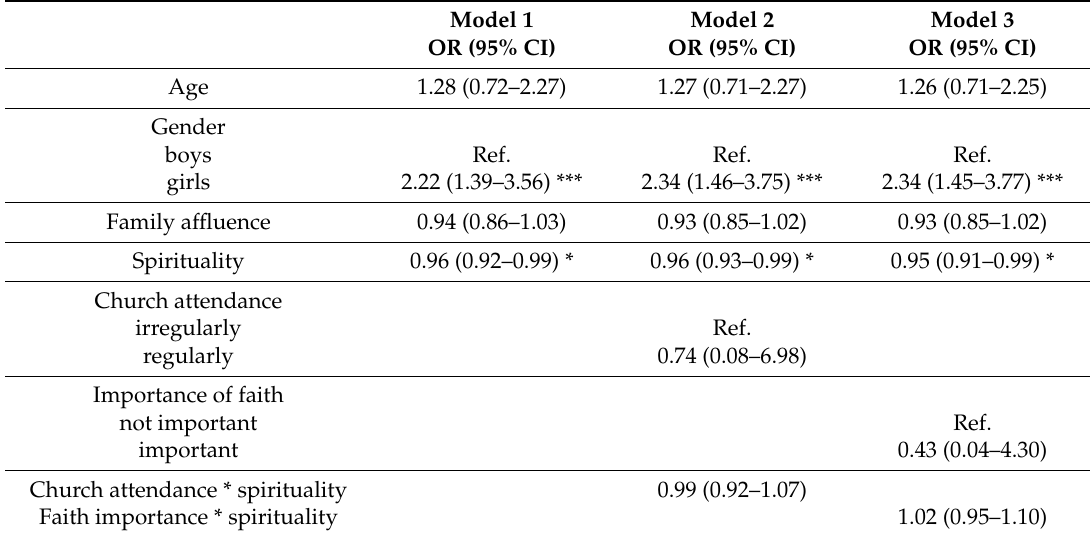
Table 2. Logistic regression with ORs and 95% CI of the association between spirituality and self-rated